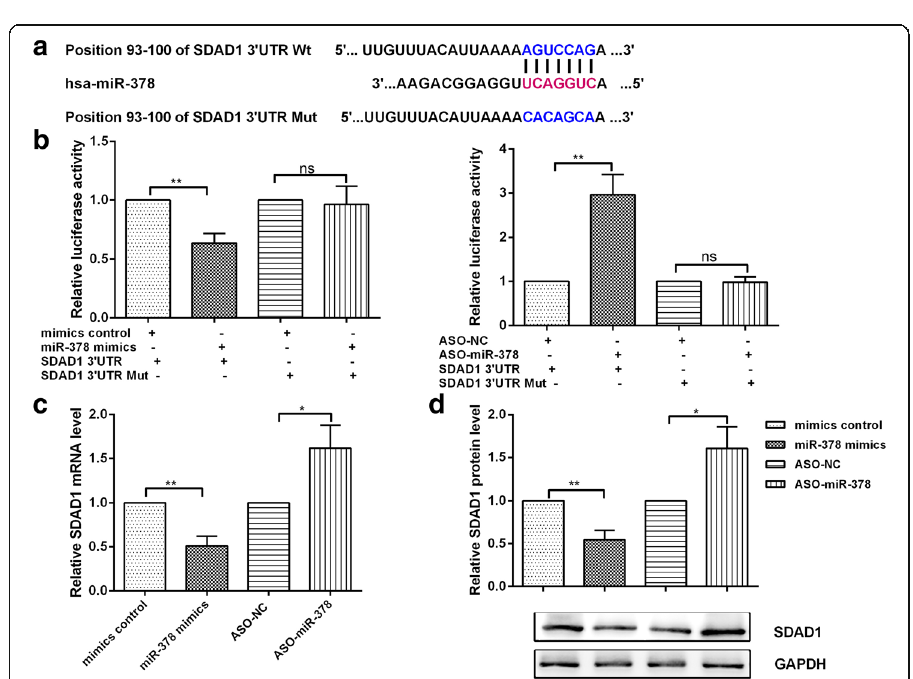
Fig. 4 SDAD1 is a direct target of miR-378. a The complementary sequences of the miR-378 binding site in SDAD1 3 ’ UTR. The sequence of mutated SDAD1 3 ’ UTR is also shown. b The effect of miR-378 on luciferase intensity controlled by the wild type (Wt) or mutant (Mut) 3 ’ UTR of SDAD1 was determined using the luciferase assay. c , d The mRNA (C) and protein (D) levels of SDAD1 were detected using quantitative RT-PCR and western blot, respectively, in SW480 cells transfected with miR-378 mimics. * p < 0.05, ** p < 0.01, ns: not significant